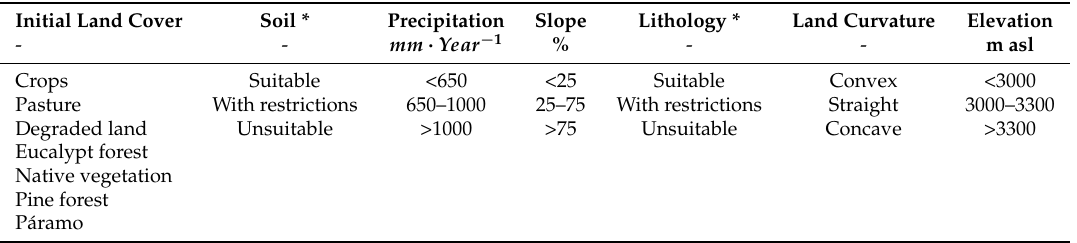
Table 1. Land characteristics consider to stratify the Tabacay dataset into land